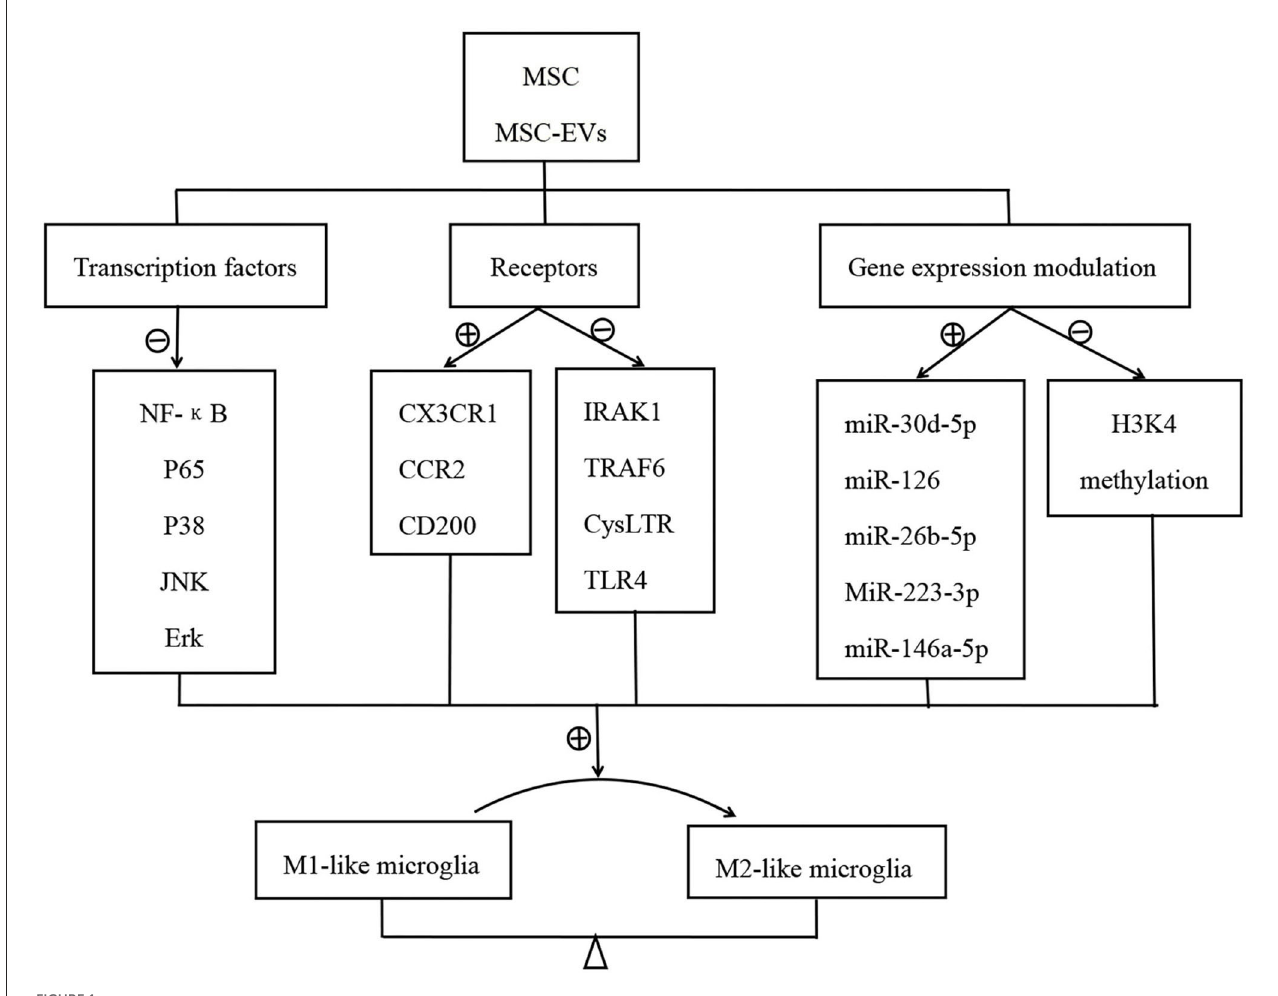
FIGURE1 Mechanisms of MSC/MSC-EVs modulating the microglia